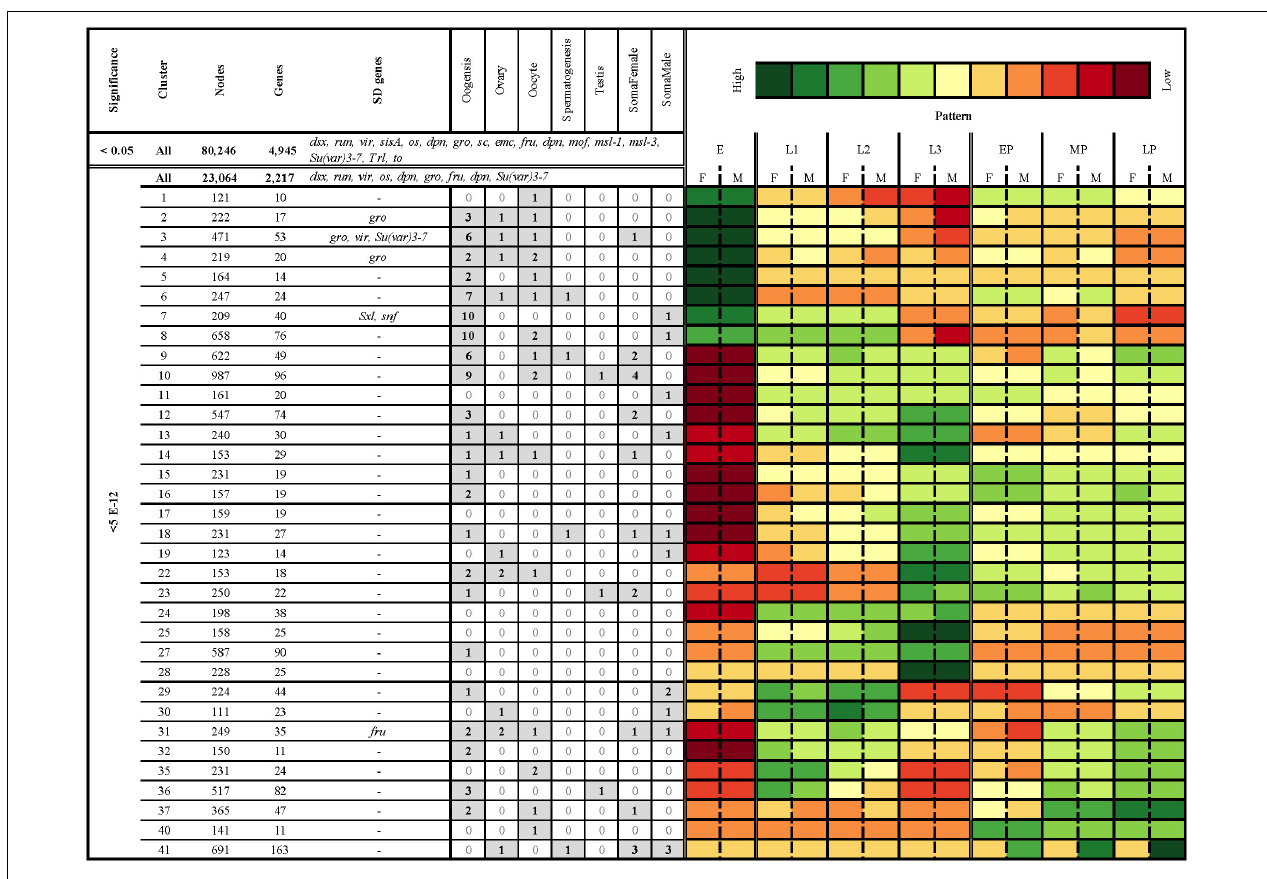
FIGURE 6 | Clustering of all significantly differentially expressed genes (FDR < 5e-12) resulted in 41 clusters with an average Pearson correlation of 0.85 and 100 nodes or more. Columns from left to right: Level of significance ( p -adjusted cut-off), cluster, number of nodes, number of D. melanogaster gene hits, D. melanogaster sex-related genes hits, number of hits to genes with tissue and/or sex specific patterns of expression from other species, and a heatmap of average logCPM expression in females (F) and males (M) in eggs (E), first instar (L1), second instar (L2), third instar (L3), early in pupariation (EP), mid pupariation (MP), and late in pupariation (LP). The sex-related gene hits are those genes which have been identified to play a crucial role in sex-determination and sexual-dimorphism in D. melanogaster (Baker et al., 1989; Erickson and Cline, 1998; Grath and Parsch, 2016). The tissue and sex-specific gene hit lists were identified a priori based on results from previous work in D. melanogaster studying somatic and gametic patterns of gene expression, including within tissues (ovaries, oocytes, and testis) and related to gametogenesis (spermatogenesis and oogenesis) (Lebo et al., 2009; Chang et al., 2011). There are three different nested sets of genes in this table. The top row ( < 0.05; All) represents all nodes identified as differentially expressed in the analyses. The second row represents all nodes differentially expressed in the analysis at a FDR cutoff of 5e-12. The remaining rows are all of the nodes in that set which are also in a cluster with an average Pearson correlation > 0.85 and 100 nodes or more (where to find data that produced this